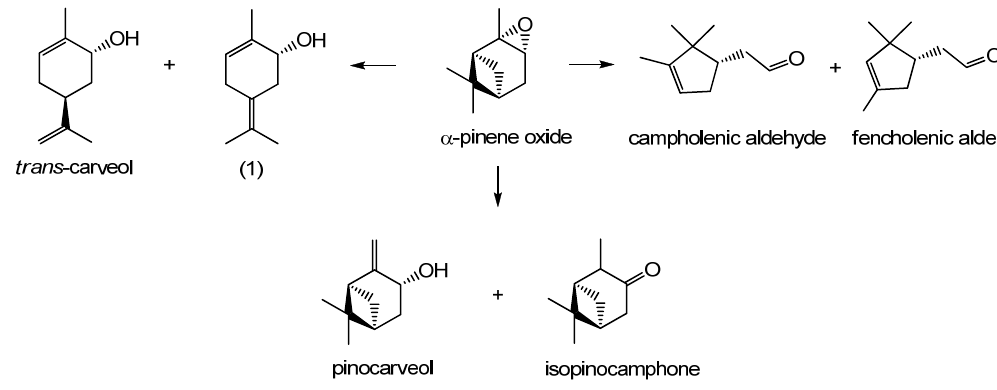
Figure 1. Reaction schemes of α -pinene oxide isomerization to trans -carveol, (1) 2-methyl-5-(propan-2-ylidene)cyclohex-2-enol, campholenic aldehyde, fencholenic aldehyde, pinocarveol and